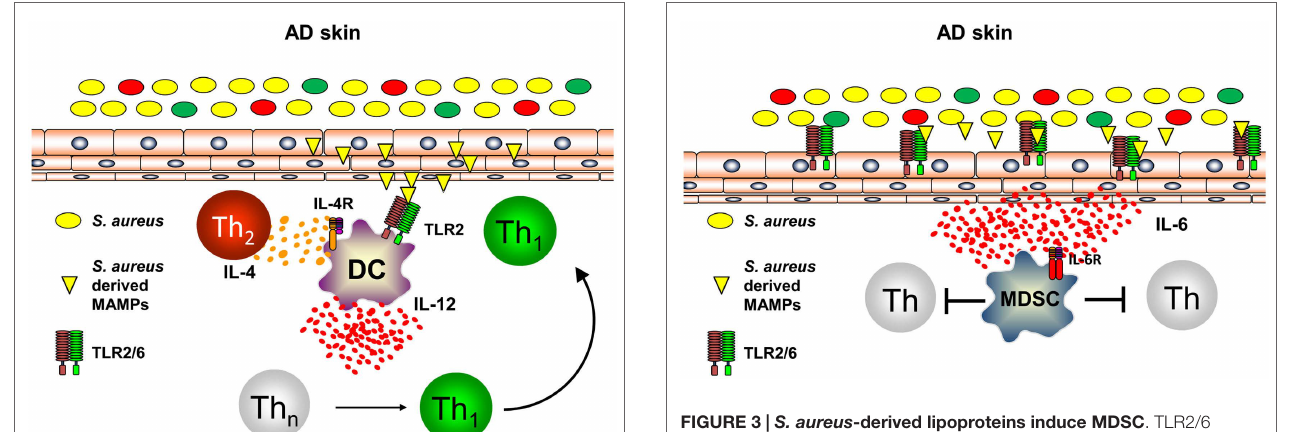
FiGURe 3 | S. aureus -derived lipoproteins induce MDSC . TLR2/6 heterodimers are expressed on skin-resident cells. Binding of diacylated bacterial lipoproteins induces IL-6 secretion leading to accumulation and activation of MDSC in the skin. T cell activation is vigorously suppressed by a NO-dependent mechanism.